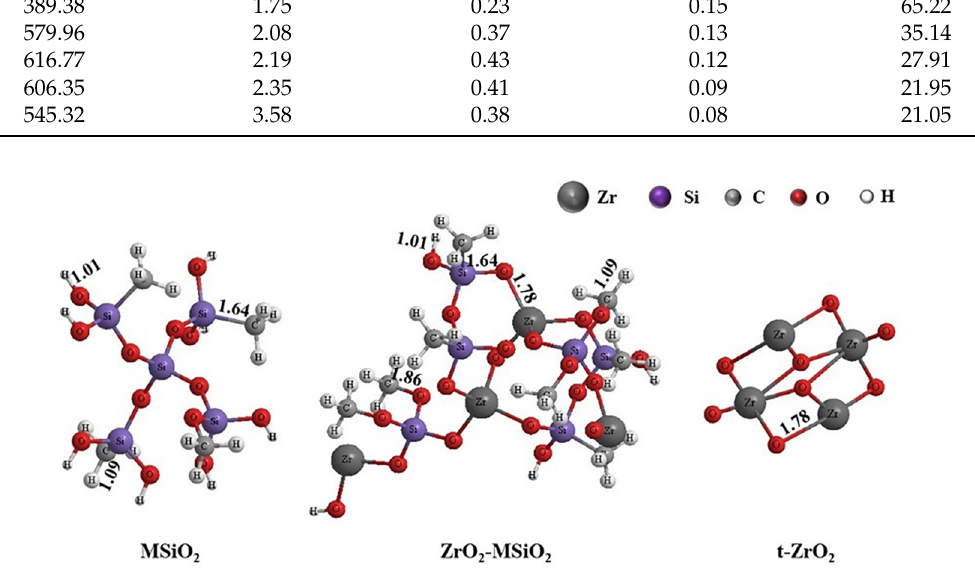
Figure 9. Molecular structural models of MSiO 2 , ZrO 2 -MSiO 2 , and t-ZrO 2